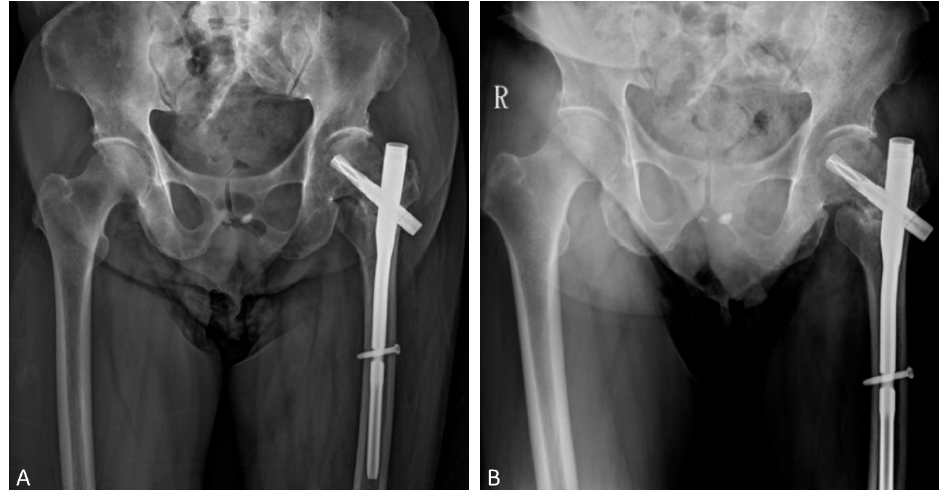
Figure 3. ( A ) 3 months ( B ) 6 months postoperative AP radiograph of the pelvis, revealing only minimal amount of callus formation. ”R” in the figure stands for “right,” which is the by default marking of laterality for plain films in the institute.